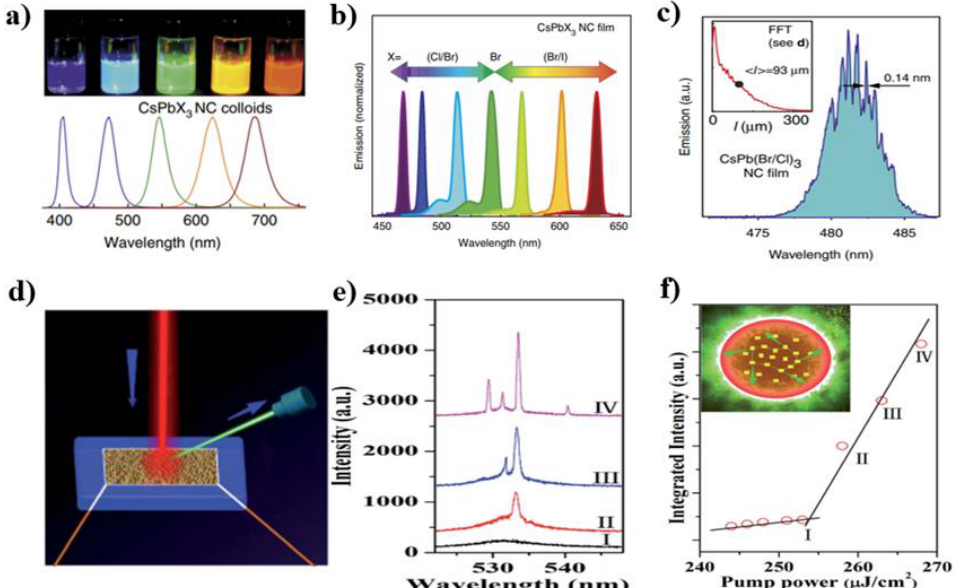
Figure 1. ( a ) Colloidal CsPbX 3 NCs. ( b ) Spectral tunability of ASE via compositional modulation. ( c ) Single pump laser shot mode structure of random lasing from CsPb(Br/Cl) 3 QD film. The inset shows path–length distribution averaged over 256 pump laser shots. The images ( a – c ) were adapted with permission from Ref. [61]. Copyright 2015 Springer Nature. ( d ) Schematic of CsPbBr 3 NCs on a silicon substrate pumped via an 800 nm femtosecond laser. ( e ) Emission spectra of the CsPbBr 3 NCs with different pump powers, showing the transition from spontaneous emission to lasing. ( f ) Integrated emission intensity as a function of pump density, showing the lasing threshold (254 mJ/cm 2 ). Inset: Schematic diagram of the formation of a closed loop path for light through recurrent scattering in the samples. The images ( d – f ) were adapted with permission from Ref. [71].